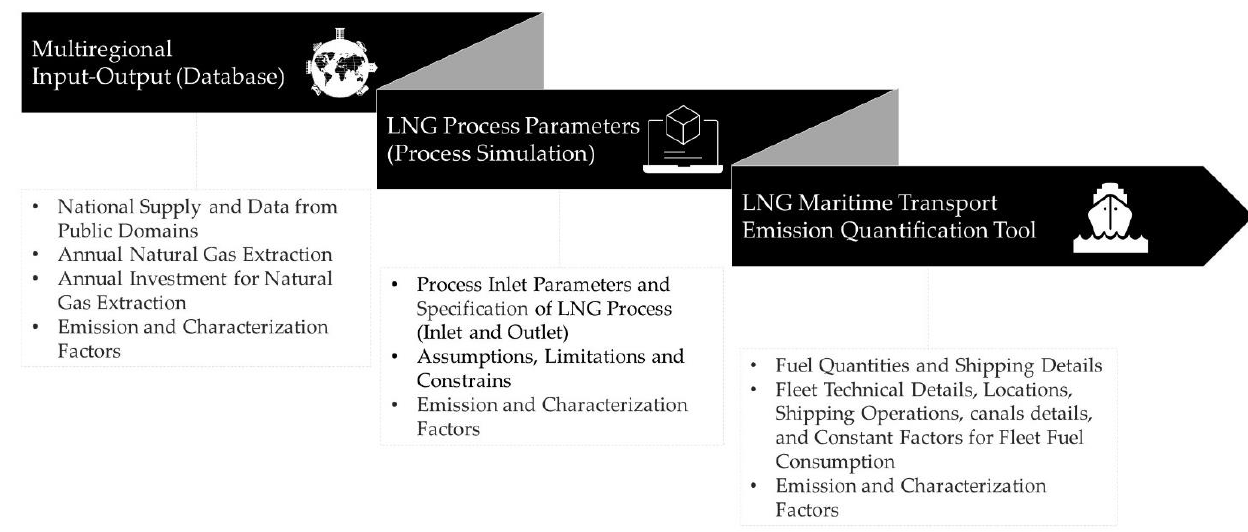
Figure 2. Research method.